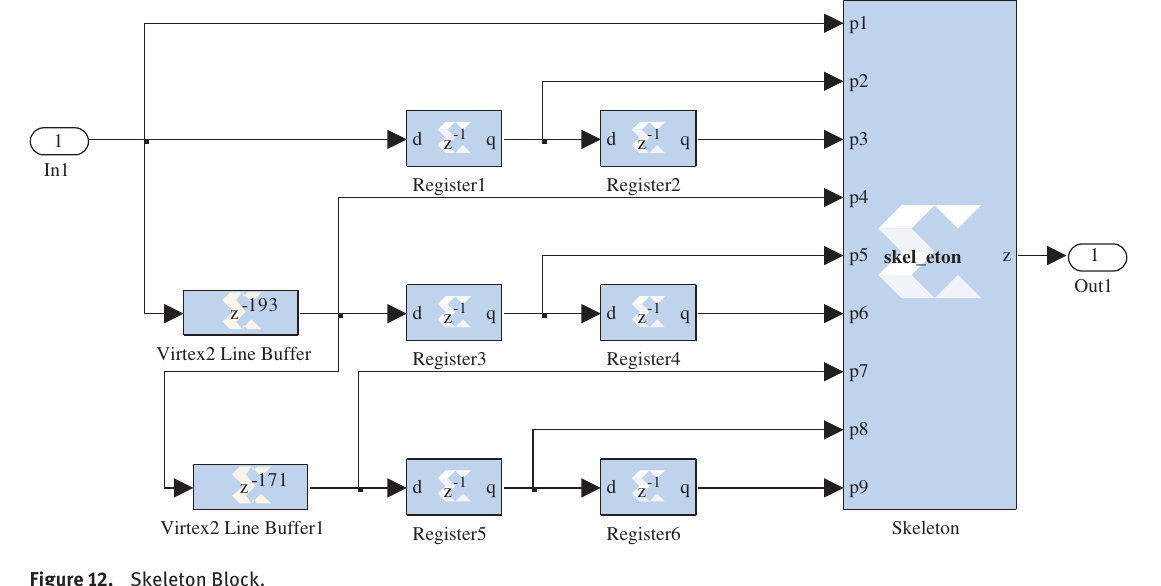
Figure 12. Skeleton Block.